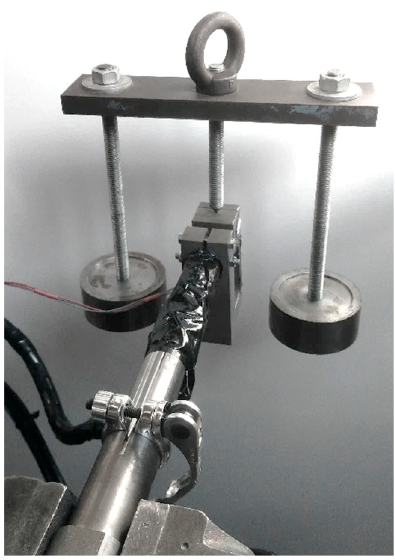
Figure 4. Setup example to relate sensor output to a known force torque combination.